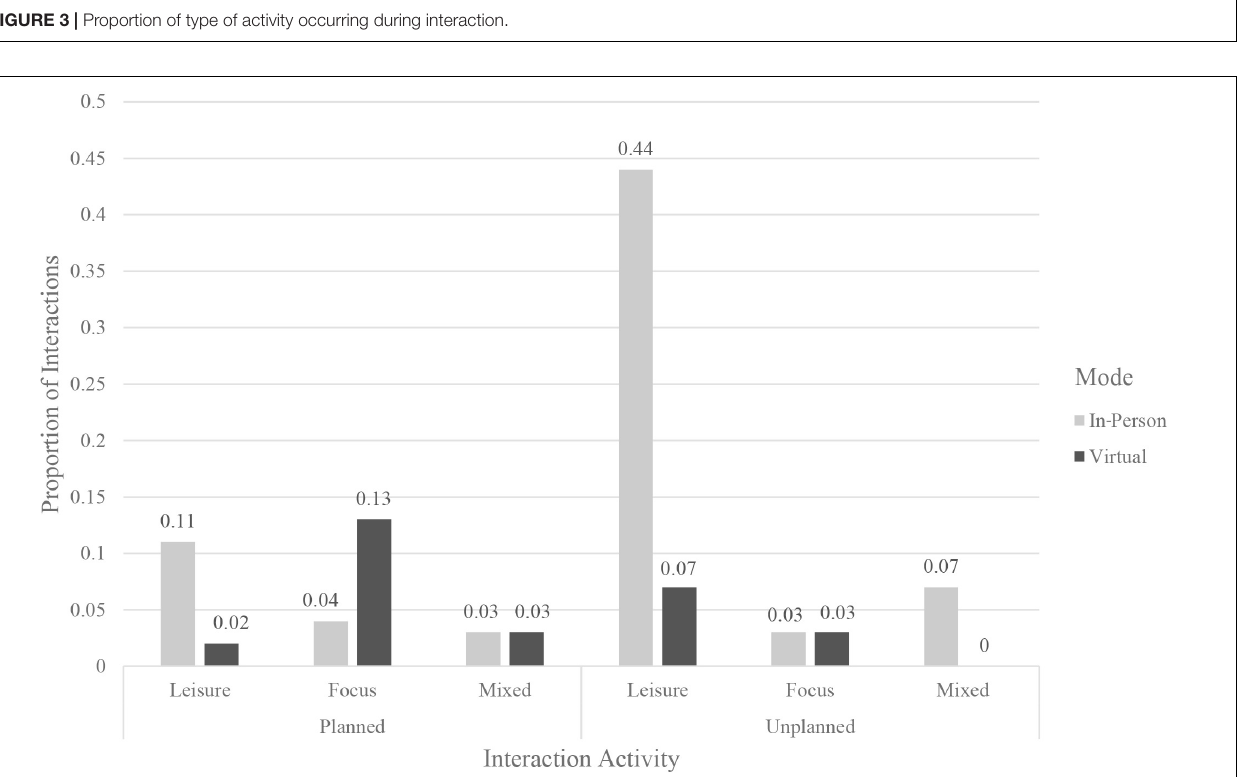
FIGURE 4 | Proportion of types of interactions, by mode and